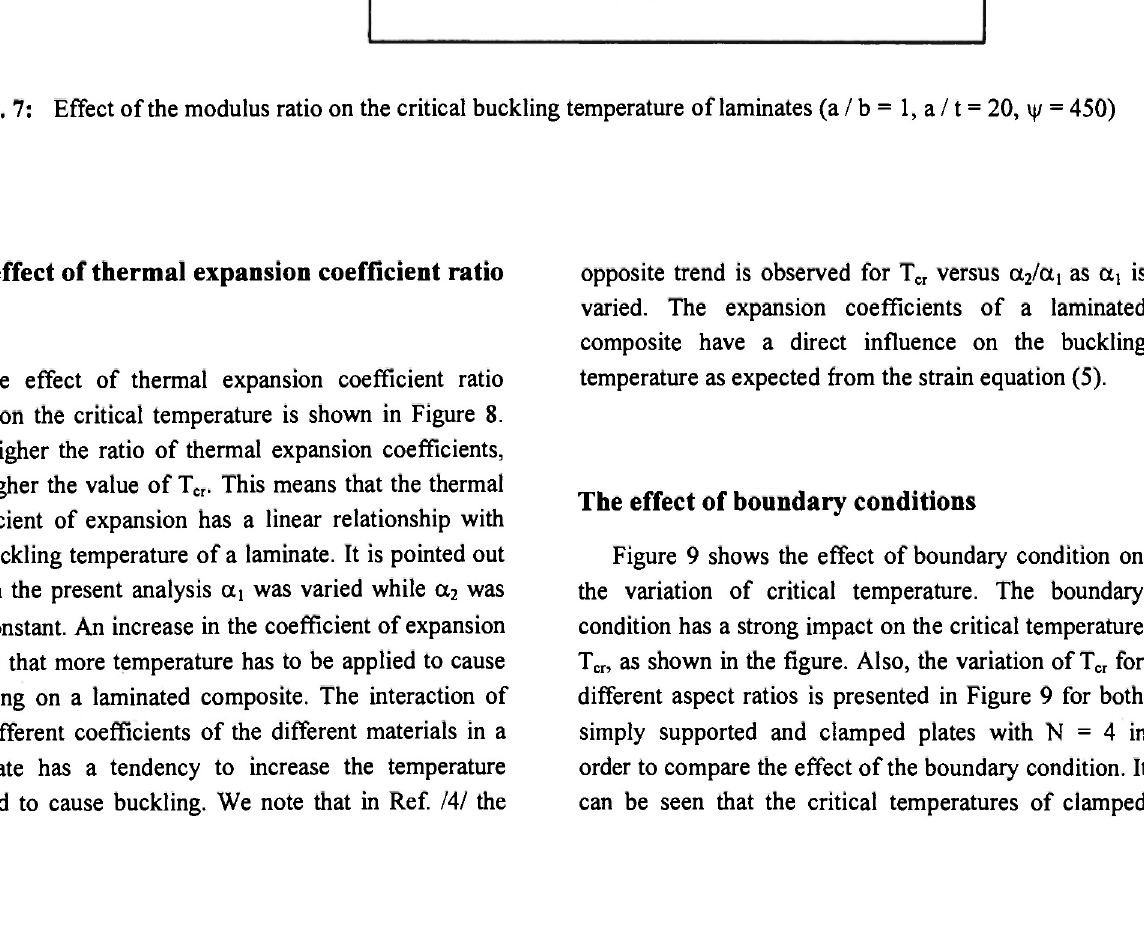
Fig. 7: Effect of the modulus ratio on the critical buckling temperature of laminates (a 7 b = 1, a 71 = 20, ψ = 450)